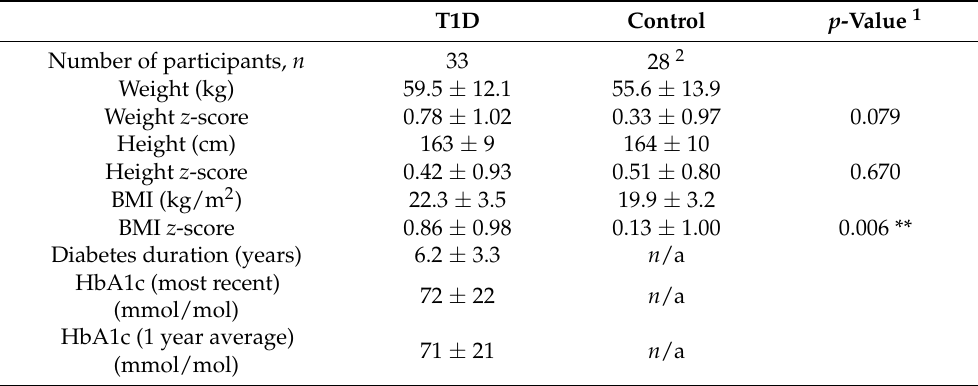
Table 2. Participant characteristics.